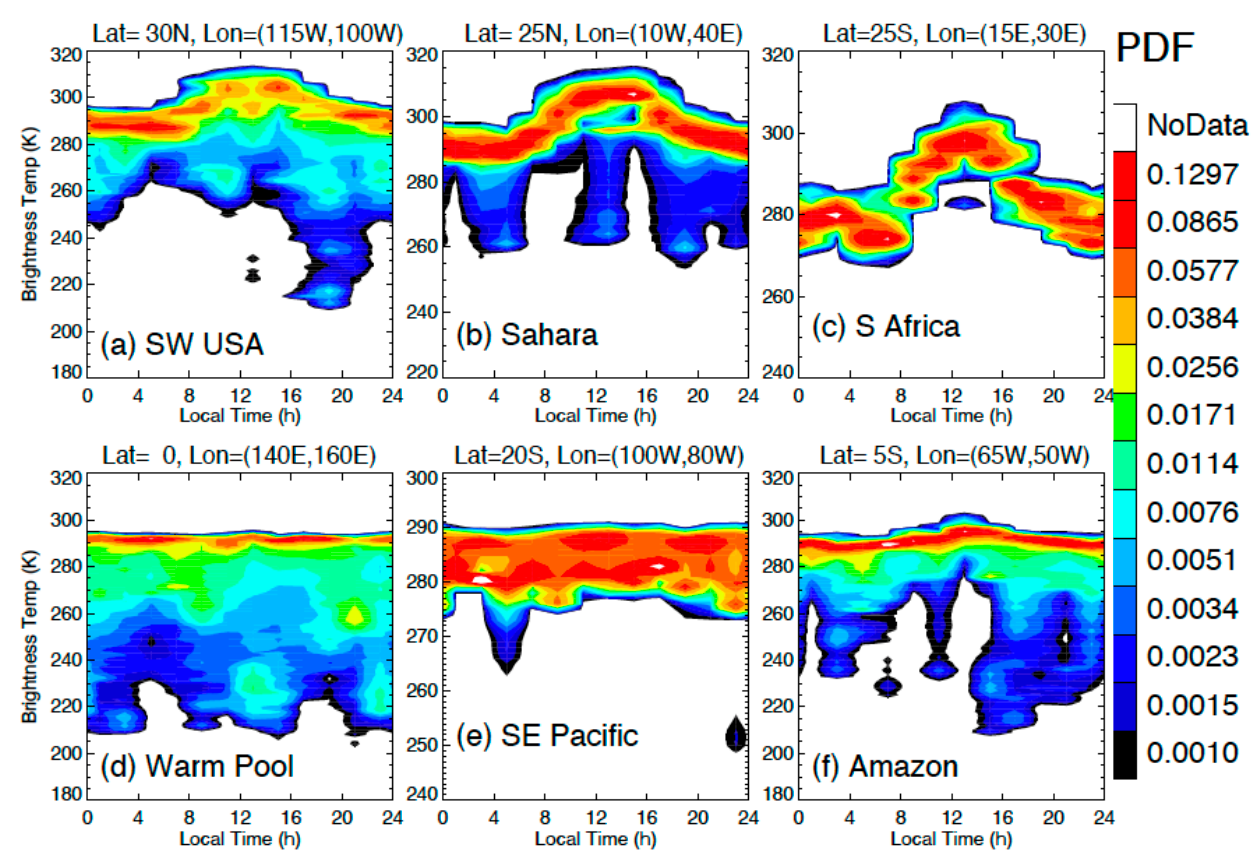
Figure 15. Diurnal variations of CTI band2 temperature PDF from selected regions: ( a ) southwest United States, ( b ) Sahara, ( c ) southern Africa, ( d ) Western Pacific Warm Pool, ( e ) southeast Pacific, and ( f ) Amazon rainforest.